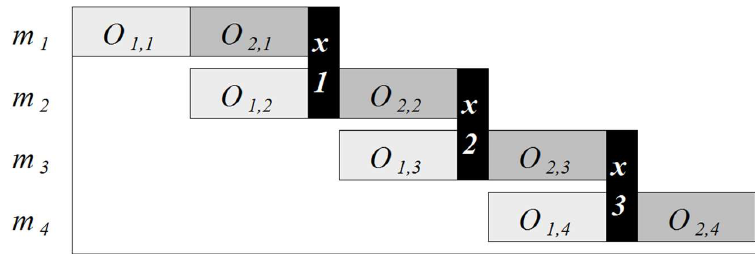
Fig. 3 Generic case of PFS schedule with 2 jobs ( j 1 and j 2 ) and 4